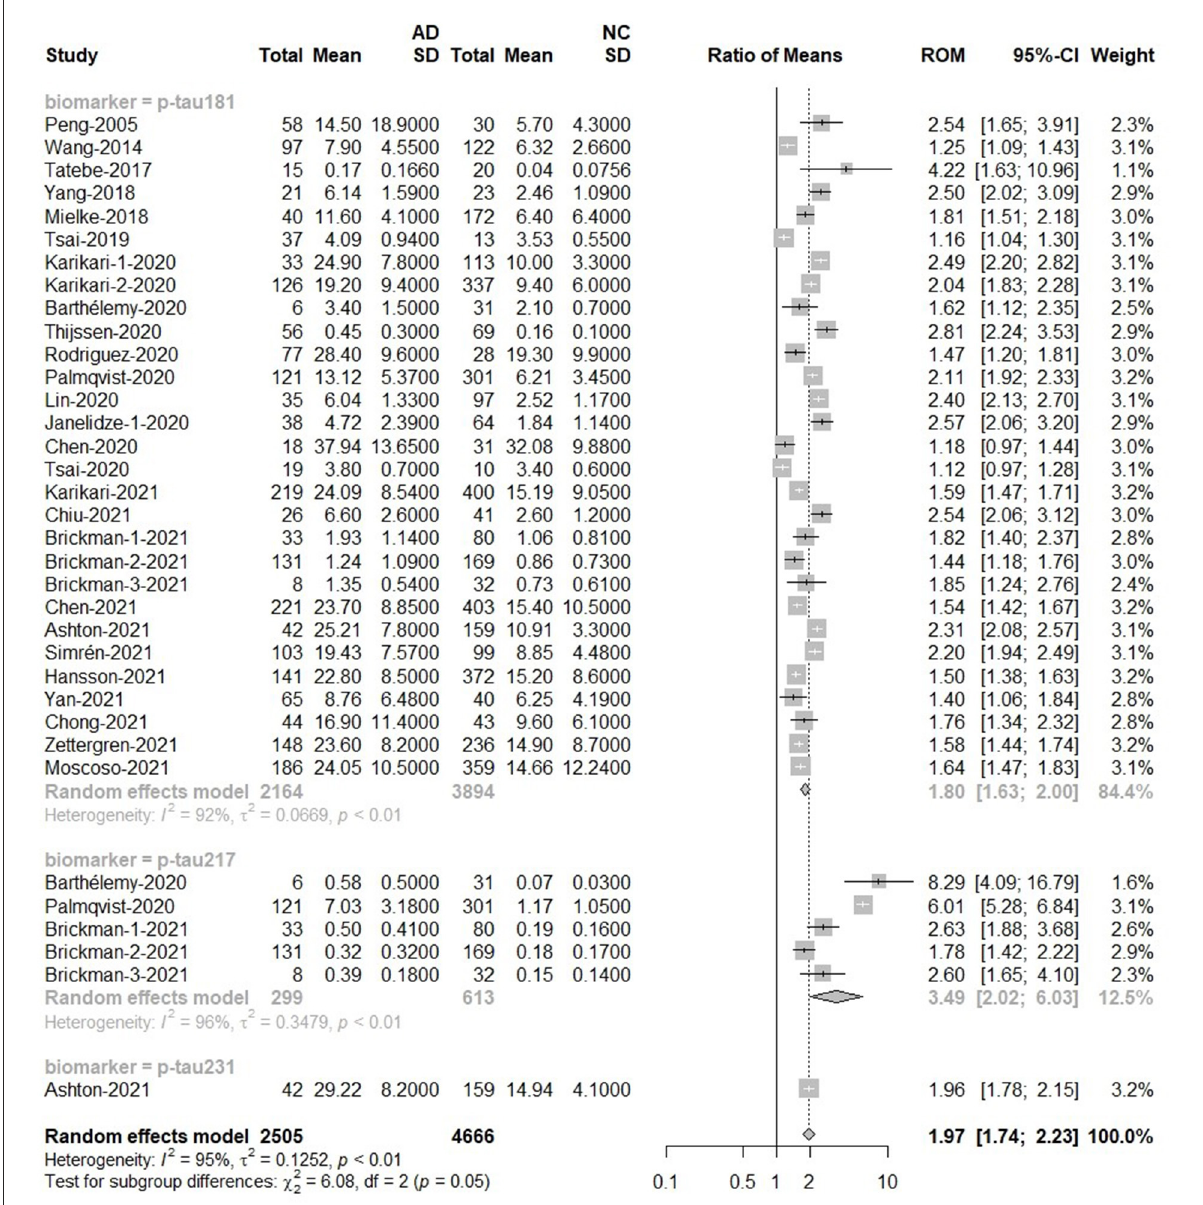
FIGURE4 AD to control ratio for blood p-tau: Forest plot of the ROMs (with 95%CI) for each tau subtype between AD and normal cognitive controls. A ROM above one means that p-tau proteins were elevated in the AD groups. Total, total sample size; Mean, mean value; SD, standard deviation; ROM, ratio of means; CI, confidence interval; AD, Alzheimer’s disease; NC, normal